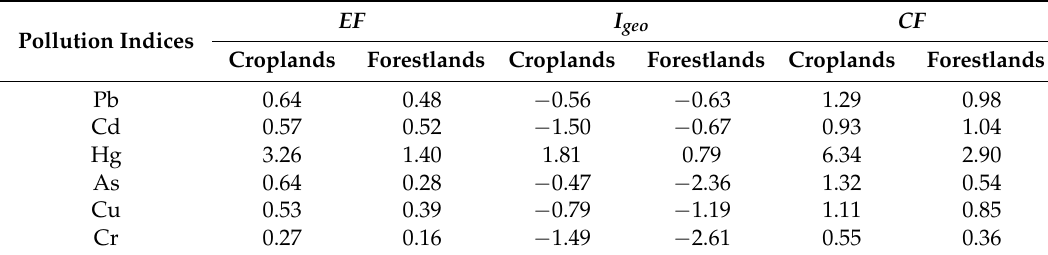
Table 3. Mean values of the pollution indices of soil samples around the JCFP